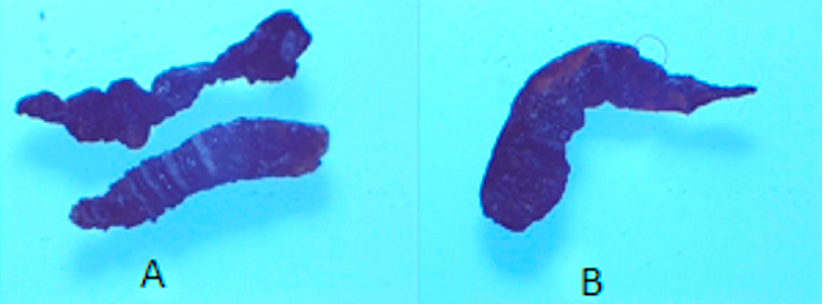
Fig. 8. Phenotypic variation observed in A: 2 nd larval stage, B: 3 rd larval stage of Musca domistica treated with 100 mg/ml prepared